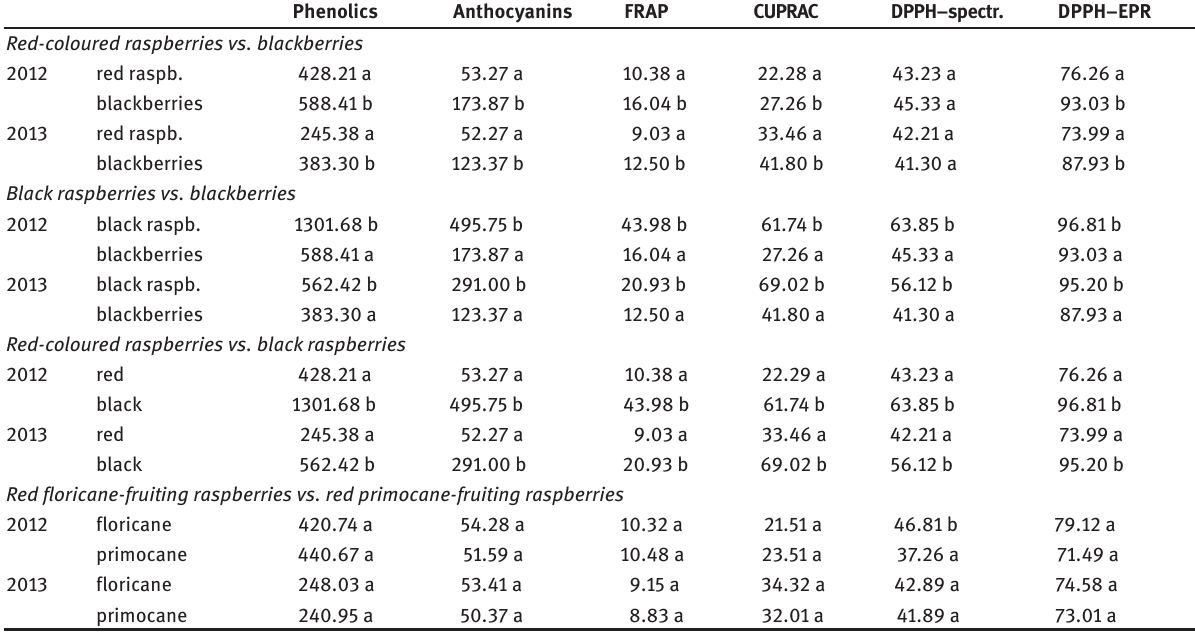
Table 7: Mean total phenolic/anthocyanin content and antioxidant capacity: a comparison between groups. Phenolics Anthocyanins FRAP CUPRAC DPPH–spectr. DPPH–EPR